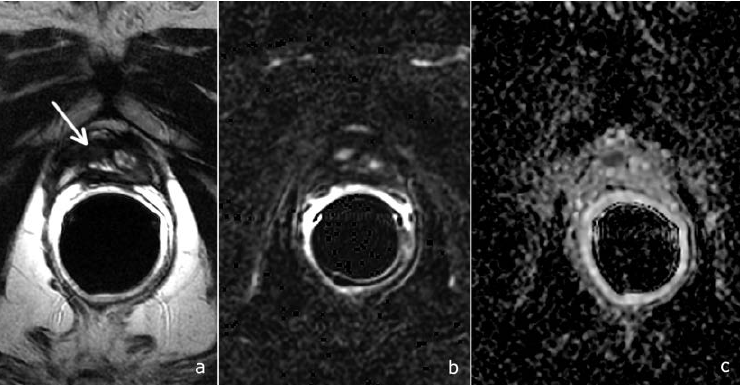
Figure 5. A PI-RR-score-5 patient, 70 years old, with a PSA value of 0.31 ng/mL. The patient underwent radical prostatectomy for bilateral prostate cancer, Gleason score 4 + 3, with bilateral surgical positive margins at the prostate apex. mpMRI documented a small hypointense tissue in the T2-weighted image, right-sided to the vesico-urethral anastomosis ( a -arrow), characterized by intense and early contrast enhancement ( b ) and restricted diffusion at the ADC map, ( c ) PI-RR score =